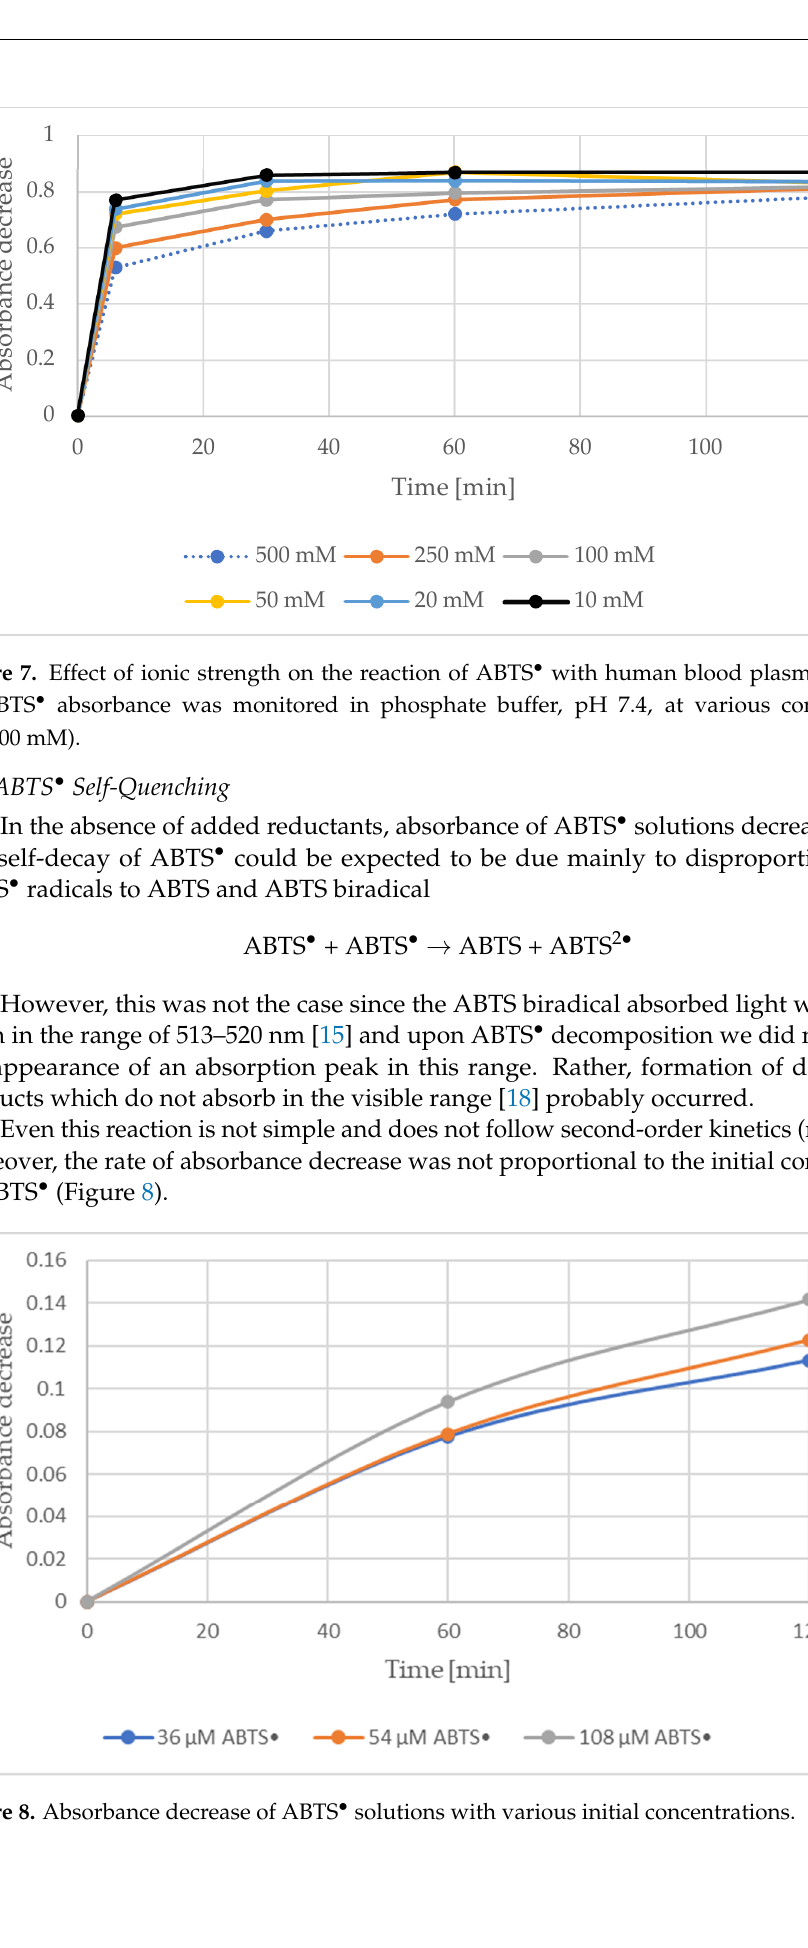
Figure 6. Effect of ionic strength on the reaction of ABTS • with Trolox (5 nmol). ABTS • reduction was measured in phosphate buffer at various concentrations (10–500 mM).